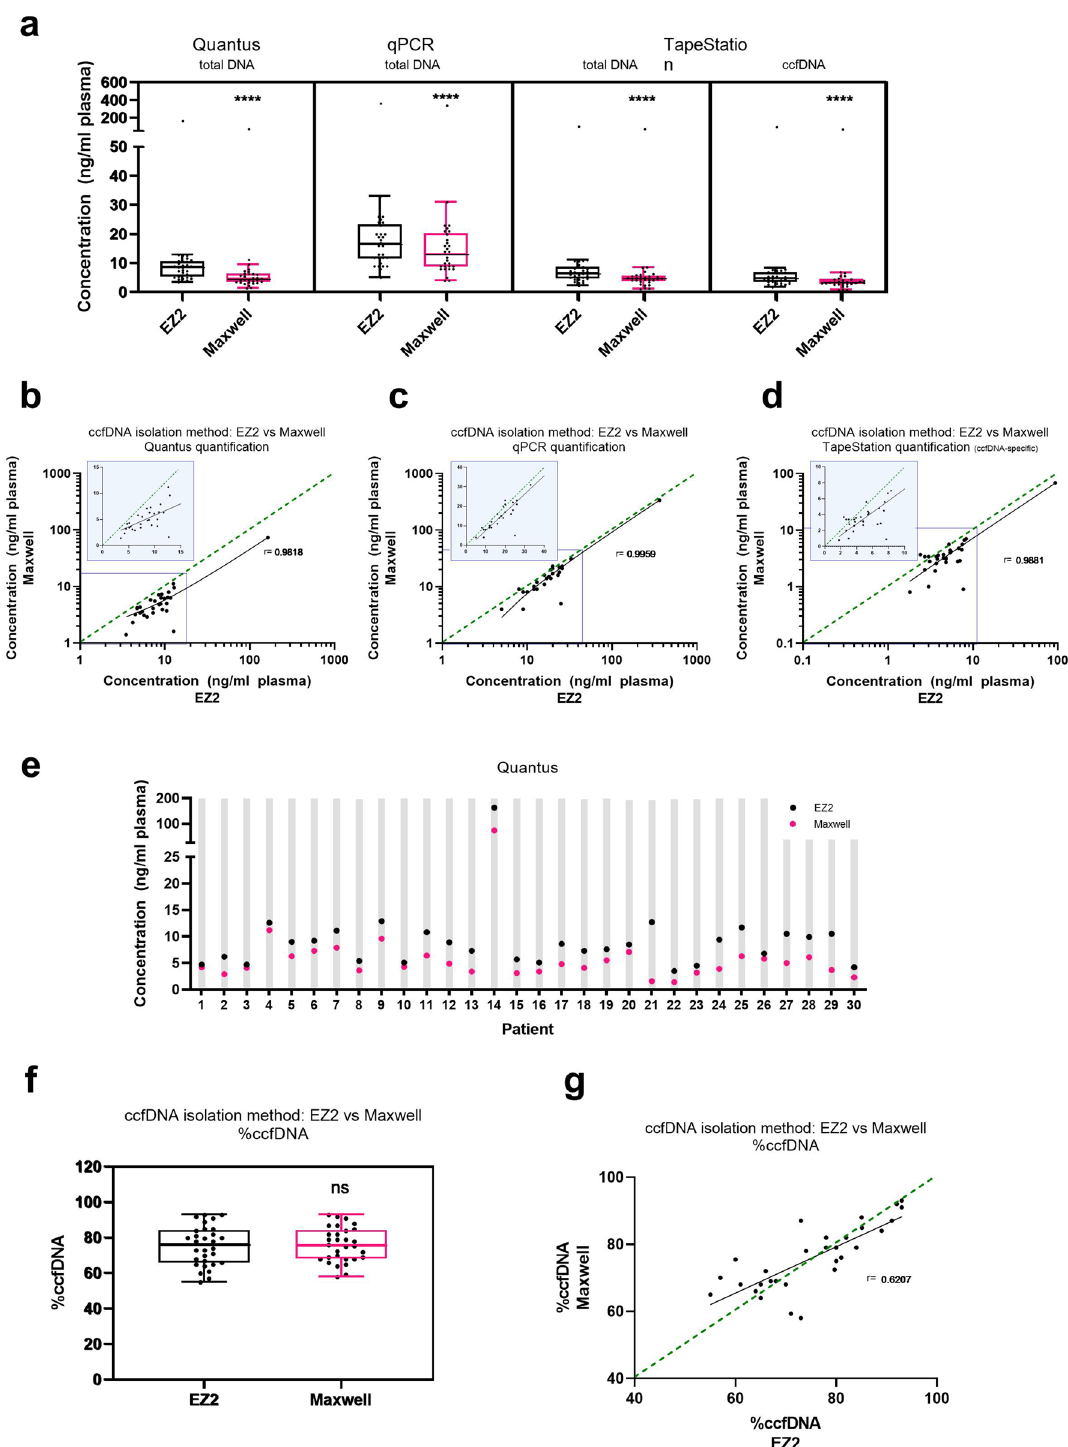
Figure 1. Concentration of isolated circulating cell-free DNA (ccfDNA). ( a ) CcfDNA was isolated from paired plasma samples using the EZ2 ccfDNA field test kit or the Maxwell RSC plasma ccfDNA kit. The concentrations (ng/ml plasma) were determined by Quantus fluorometer, quantitative real-time-polymerase chain reaction (qPCR), or TapeStation analysis. The central line in the box plot represents the median value and the whiskers are Tukey whiskers. Correlations of ccfDNA concentrations in EZ2 samples with ccfDNA concentration of Maxwell samples were evaluated for quantification by ( b ) Quantus fluorometer, ( c ) qPCR quantification, and ( d ) TapeStation. The green dashed line represents the bisector, and the solid black line the linear regression. The blue graph inserts represent magnifications of the marked areas of the original graph. ( e ) Concentrations of ccfDNA isolated by the EZ2 and Maxwell kits and quantified using Quantus fluorometer were presented for each patient. ( f ) The percentage of ccfDNA (%ccfDNA) was measured and calculated using TapeStation analysis. ( g ) Percentages of ccfDNA per samples isolated using the Maxwell kit were correlated with ccfDNA percentages of samples isolated using the EZ2 kit. The central line in the box plot represents the median value and the whiskers are Tukey whiskers. ****, p ≤ 0.0001. n =